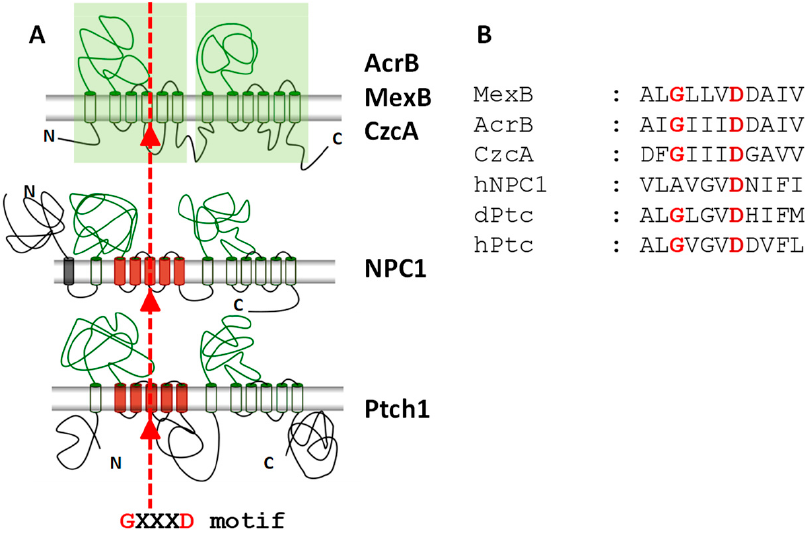
Figure 2. Ptch1 sequence homologies with the Niemann-Pick disease type C1 protein (NPC1) and the bacterial transporters from the RND family such as AcrB, MexB and CzcA. ( A ) Protein topology. The sterol sensing domains (SSD) are represented in red, and the transmembrane segment containing the highly conserved GXXXD motif is indicated. ( B ) Sequence alignment of the highly conserved GXXXD motif.